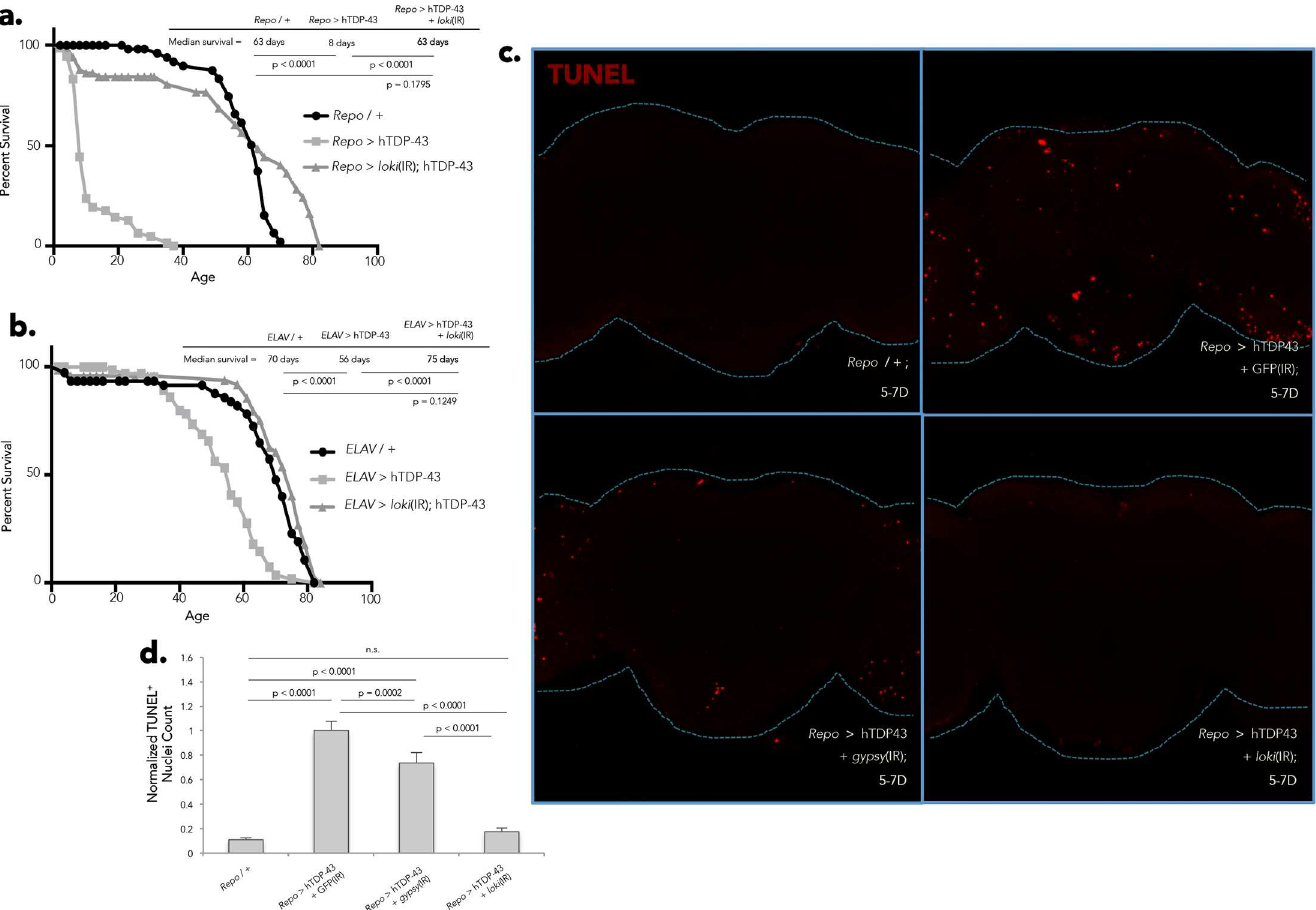
Fig 5. DNA damage-induced cell death and gypsy ERV expression contribute hTDP-43 mediated toxicity. (A) Lifespan analysisshows that co- expressionof loki (IR) ( Repo > loki (IR) + hTDP-43) fully rescues the lifespan deficit exhibitedby flies expressingglial hTDP-43 ( Repo > hTDP-43). (B) Co- expressionof loki (IR) ( ELAV > loki (IR) + hTDP-43) likewisefully rescues the lifespan deficit exhibitedby flies expressingneuronal hTDP-43 ( ELAV > hTDP-43). (C) Centralprojectionsof whole-mount TUNEL stainedbrains reveal a noticeable reductionin the apoptotic activity inducedby glial hTDP-43 expression( Repo > hTDP-43 + GFP(IR)) when gypsy expressionis knocked down ( Repo > hTDP-43 + gypsy (IR)), whileknockingdown loki completely alleviates the apoptosisinducedby glial hTDP-43 expression( Repo > hTDP-43 + loki (IR)). (D) Quantification of (H), normalized to the positive control ( Repo > hTDP-43 + GFP(IR)). N = 12 for Repo / +; N = 9 for Repo > hTDP-43 + GFP(IR); N = 7 for Repo > hTDP-43 + gypsy (IR); and N = 7 for Repo > hTDP-43 + loki (IR). * All of the lifespanswith the exceptionof the NRTI feedingexperiments shown in Figs 4 and 5, were performed concurrently in order to ensure comparability across groups. Therefore, appropriate controls are sharedacross